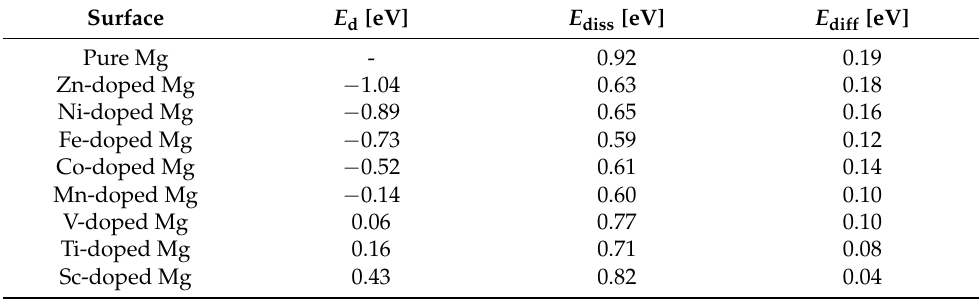
Table 7. The d band center position with respect to the Fermi energy ( E d ), the activation energy barrier for the dissociation of H 2 ( E diss ), and the activation energy barrier for the diffusion of atomic H ( E diff ) when the TM atom is placed in the subsurface of Mg(0001) (TM is capped by the kicked-out Mg atom)